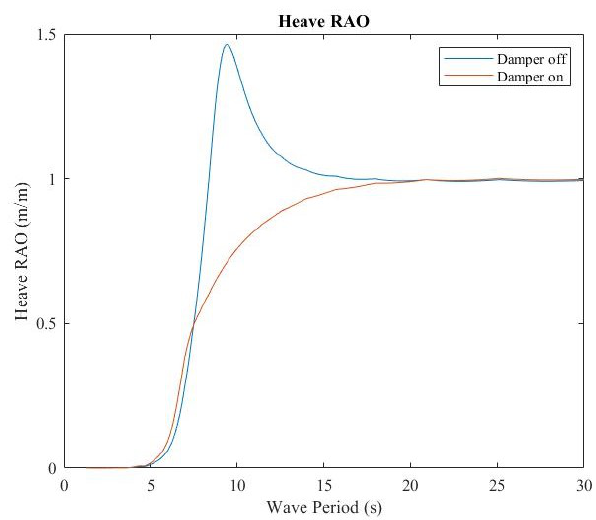
Figure 22. RAO comparing the platform heave with the TMD on and